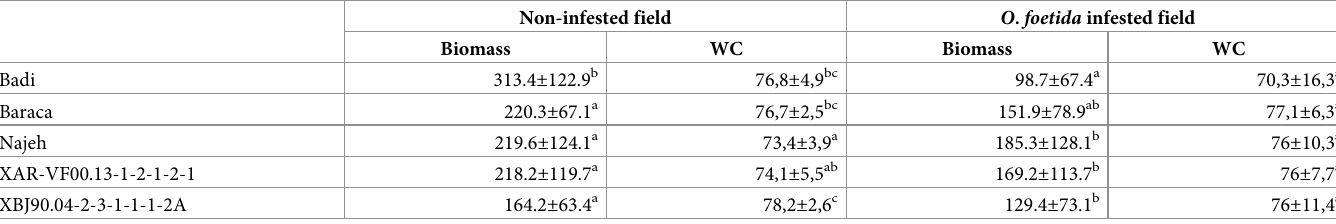
Table 4. Biomass and water content (WC) recorded for different studied genotypes in both O . foetida infested and non-infested